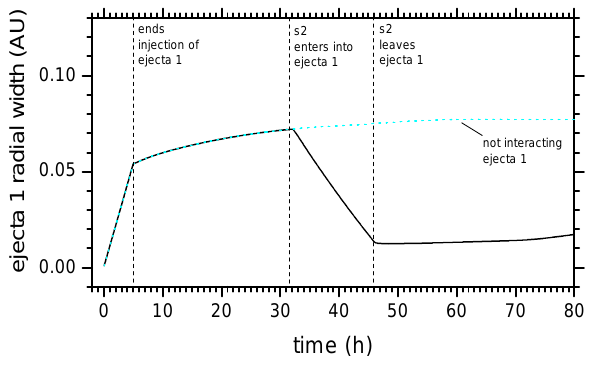
Fig. 4. Heliocentric evolution of the radial width of ejecta 1 (dis- tance between its front and tail). The dotted curve shows the contin- uous expansion when there is no interaction with other disturbance.